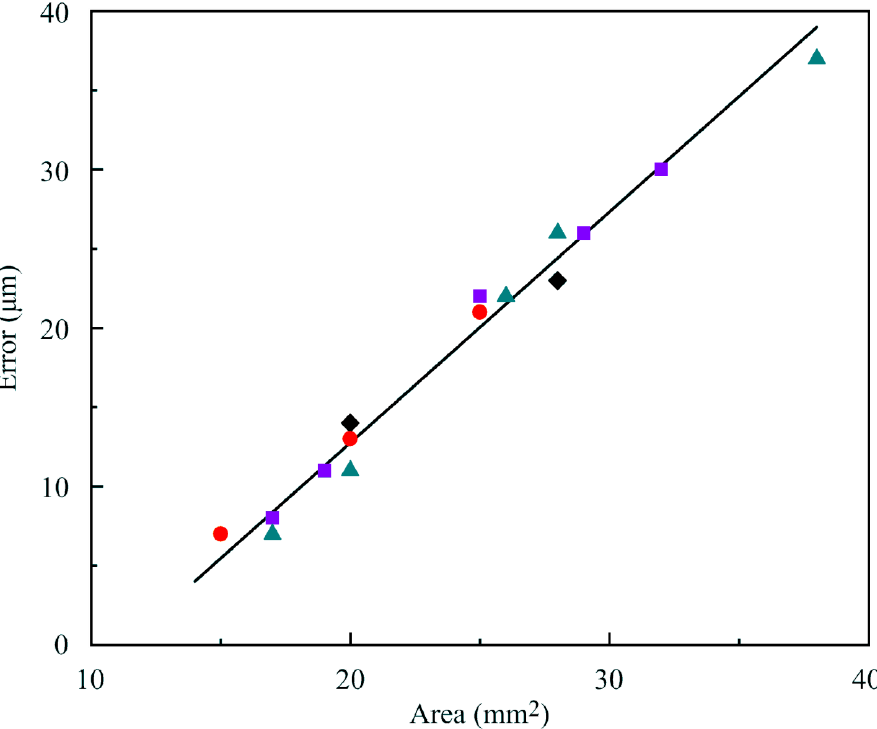
Figure 3. Dependencies of the Error on the drop surface area for pure water drops and four different capillaries: (cid:7) , 1.5; • , 2.0; (cid:4) , 2.8 and (cid:78) , 3.0 mm in diameter. For all capillaries, the ratio of drop volume to its surface area was chosen within the range of 0.4-0.58 mm.